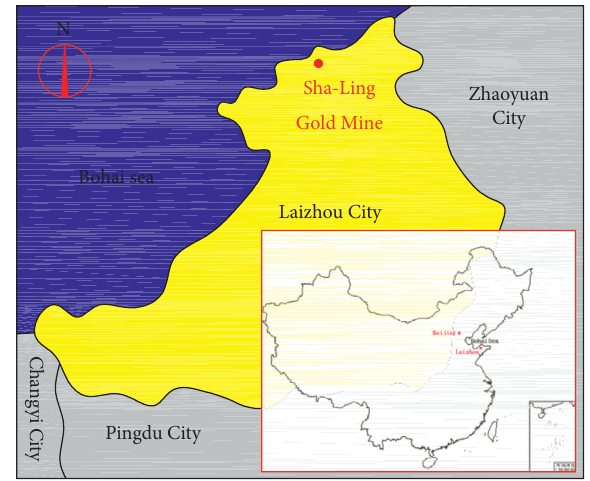
Figure 1: Location of Sha-ling gold mine. Table 1: The original support parameters of − 1114m to − 1124m shaft lining and the − 1120m ingate of the air intake shaft. Support parameter Deep Primary support Second-time support − 1120m ingate